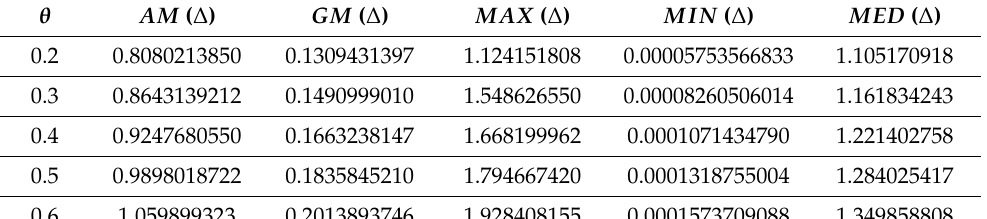
Figure 1. Graph of aggregate functions AM and GM for , τ = 2 and different values θ